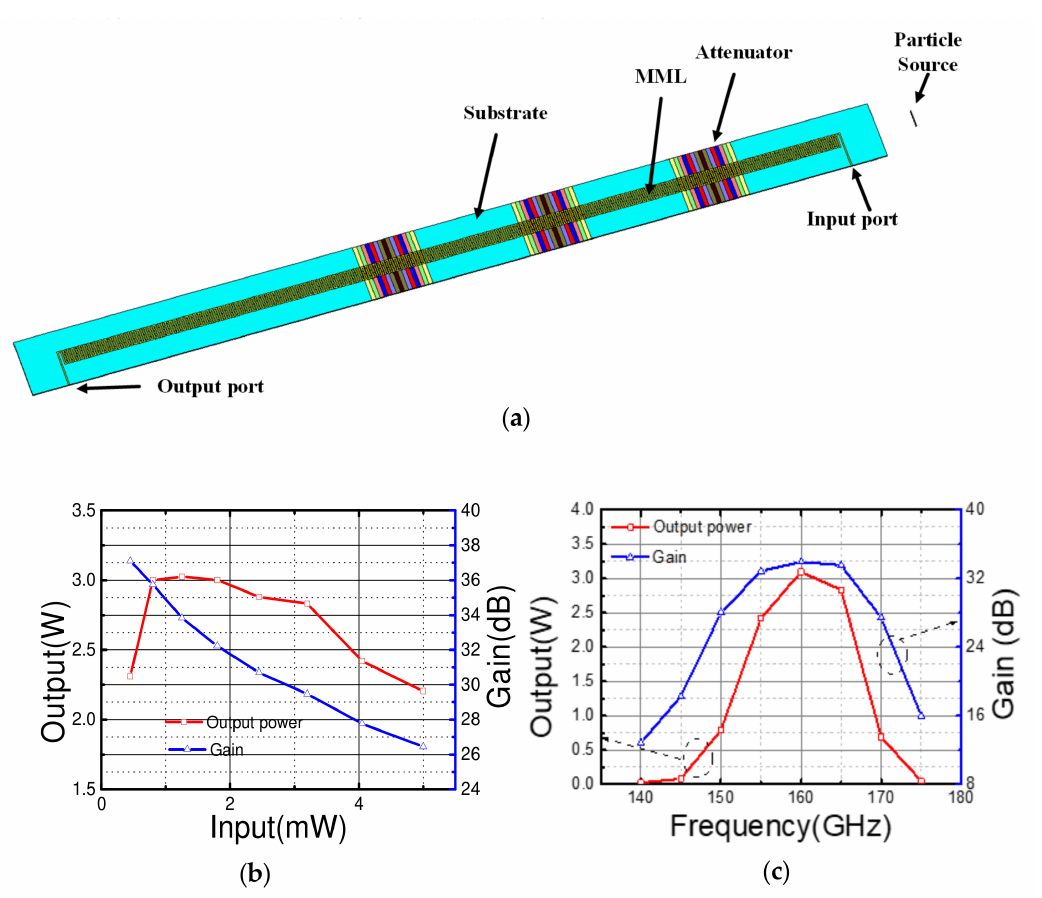
Figure 6. ( a )Schematic model for PIC simulation; ( b ) output power and gain versus input signal power; ( c ) output power and gain versus